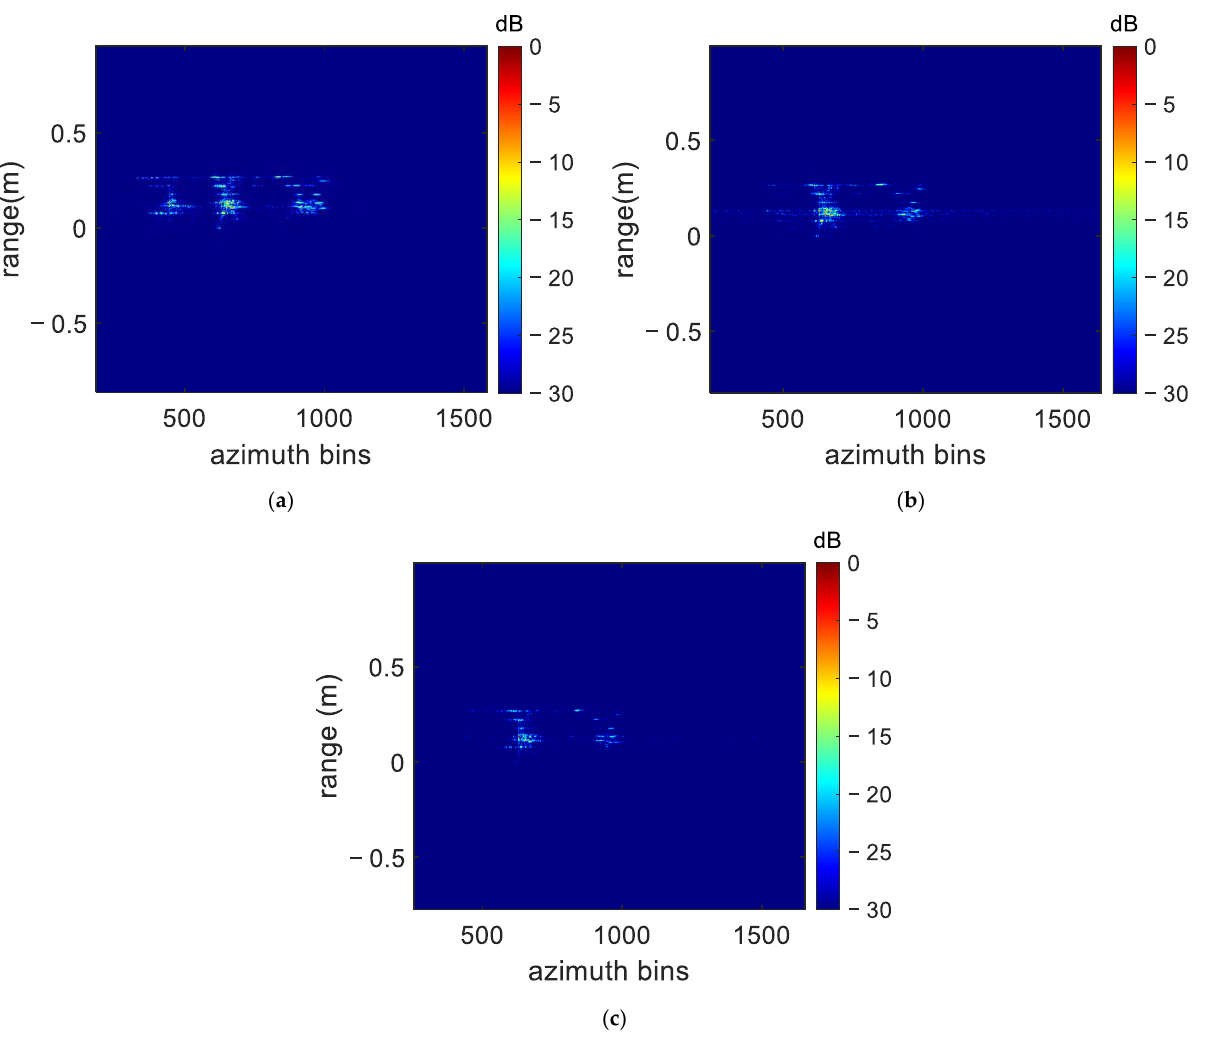
Figure 10. The imaging results of different algorithms: ( a ) FP-MEA; ( b ) N-MEA; ( c ) DN-MEA. Similarly, for the purpose of analyzing the azimuth resolution and side lobe suppres- sion of the proposed algorithms, the azimuth profile was selected to compare the −3 dB width. For the convenience of illustration, the scattering point located at the lower left wing was selected as an example to intuitively analyze the focus performance with DN-MEA. Figure 11 shows the azimuth profiles of FP-MEA, the N-MEA, and DN-MEA. The width of the main lobe was about 0.044, 0.029, and 0.018 m in sequence. In radar imaging, if the side lobes are too high, the closely spaced scattering points produce side lobes–main lobes and side lobes–side lobes overlapping effects, resulting in the misrepresentation of the amplitude peaks on the response of the real points. Especially, the side lobes of strong scattering centers causes a misunderstanding of the targets and misalignment of the main lobe, which destroys the image quality. Figure 11 shows that higher side lobes occur when using the FP-MEA imaging method, while the proposed method had narrow main lobes and low side lobes, which was consistent with the visually observed imaging results.